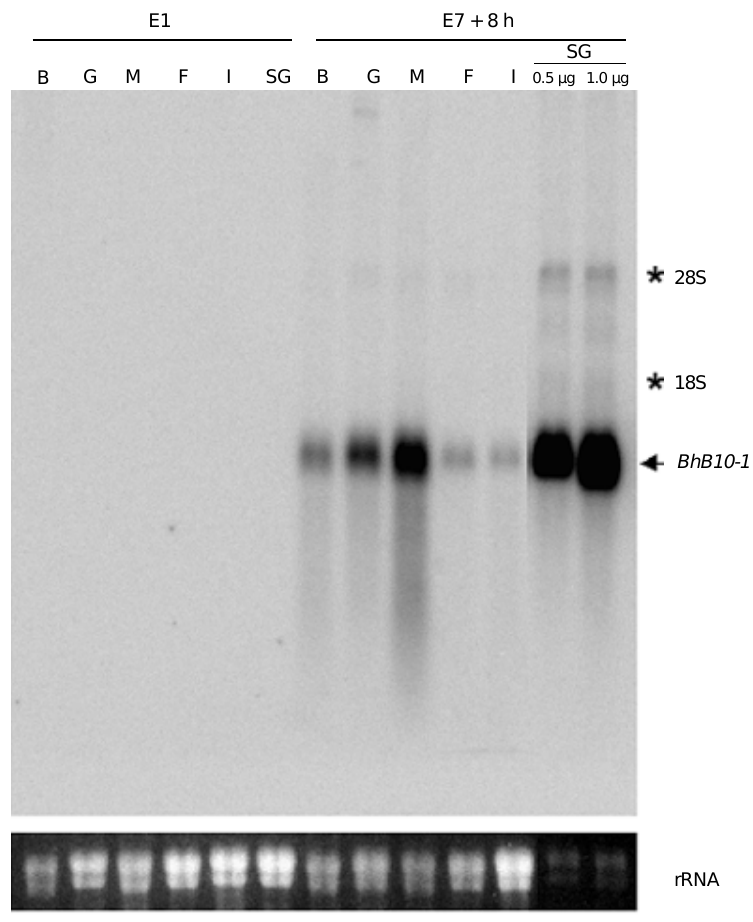
Figure 1. Developmental pattern of expression of the BhB10-1 gene in Bradysia hygida . Upper autora- diograms , 50 µg of total RNA extracted from em- bryos (E), second- and third-instar larvae (L2,3), fourth-instar larvae at stage before DNA puff forma- tion (E1) and adults (A); 2.5 µg of total RNA from whole fourth-instar larvae at the time when the first group of DNA puffs expands (E7), whole fourth- instar larvae (+8) or carcasses (C) from larvae 8 h after E7 when puff B10 is maximally expanded and young pupae (P), and 0.25 µg of total RNA extracted from salivary glands (SG) of larvae at stage E7 + 8 h. The RNAs were analyzed with a ribonuclease protec- tion assay (RPA) with an antisense probe comple- mentary to the BhB10-1 gene. The protected frag- ment is 316 bp long ( BhB10-1, arrow). The higher